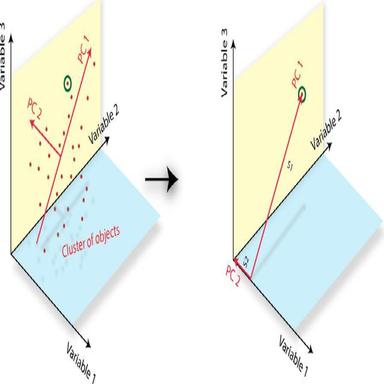
Action of PCA for a schematic dataset with many objects and three variables. (a) shows how the PCA reduces the data set to show strong variation along one principal axis, which may not be an axis of the initial data set; (b) shows how varying the weighting of two combined data sets, which present as information along different axes, can change the variance and therefore the separation of the data sets. Note that this is a simplified schematic for the purposes of visualisation, as our datasets contain tens o